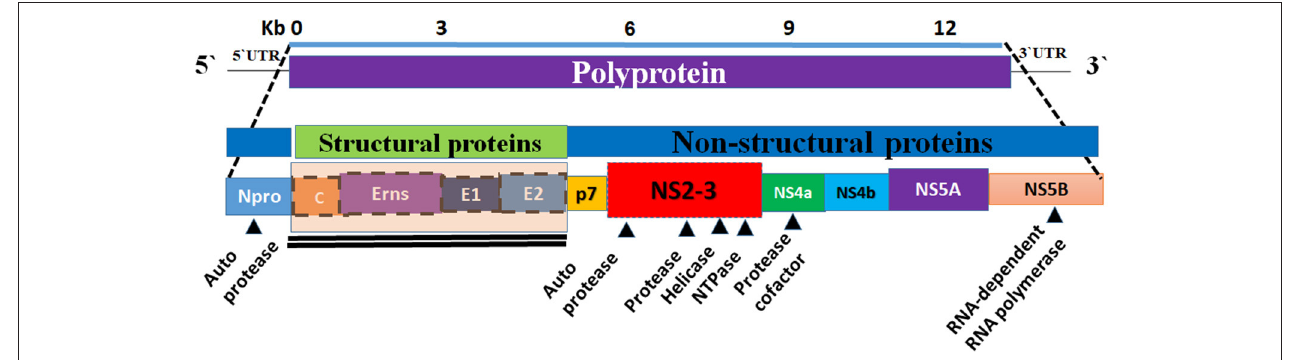
FIGURE 2 | Graphical representation of the genome organization of BVDV. The BVDV genome is composed of a single strand of RNA (the bottom panel). The viral genome encodes a polyprotein (top panel). The central panel showing the composition of the viral genome (the structural and non-structural proteins). Eight non-structural proteins (Npro, p7, NS2, NS3, Ns4a, NS4b, and NS5b) and four structural proteins (C, Erns, E1, and E2) are encoded by polyprotein (middle and bottom panels). The non-structural proteins are encoding the viral proteases, helicase, NTPase, and